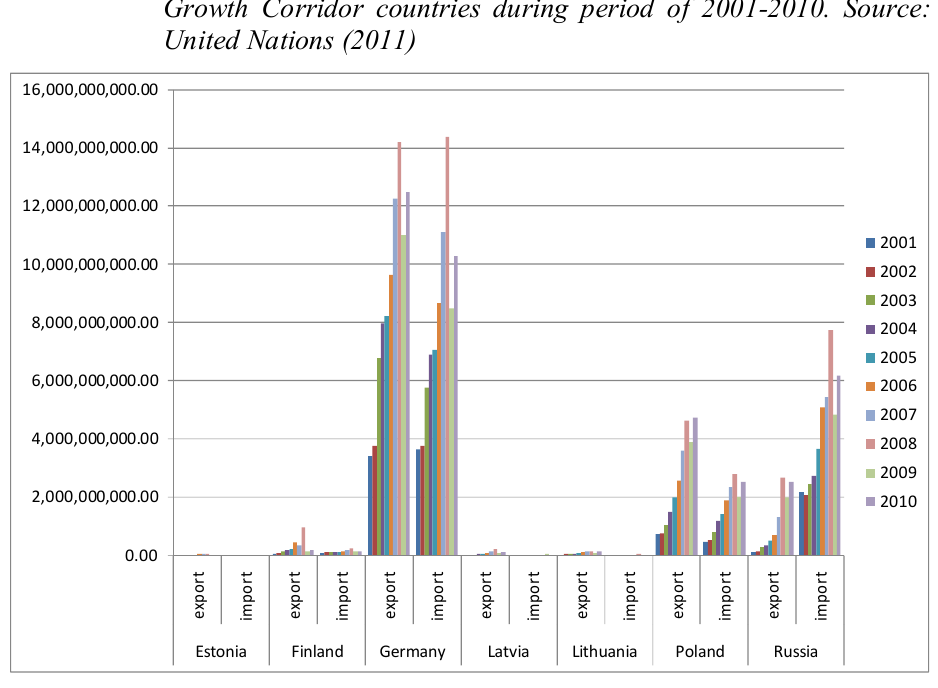
Figure 6 Slovakian import and export (both in USD) with different Rail Baltica Growth Corridor countries during period of 2001-2010. Source: United Nations